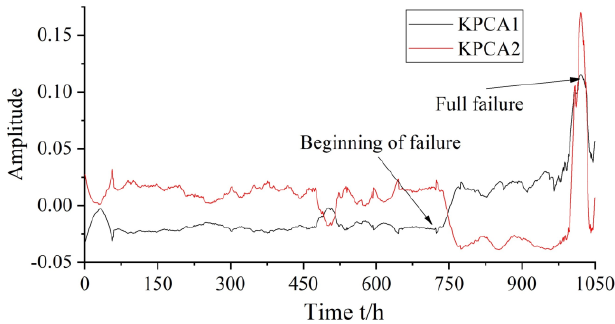
Figure 10. First and second principal components obtained by KPCA method.